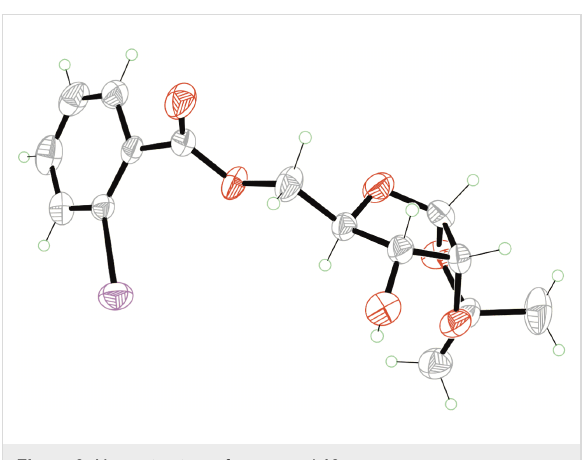
Figure 3: X-ray structure of compound 13